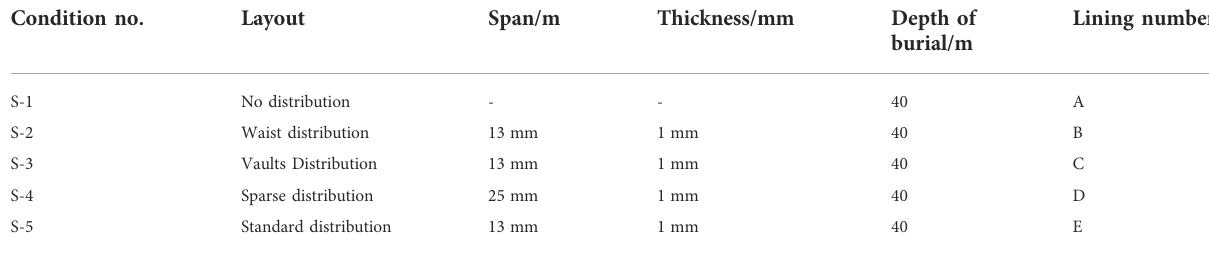
TABLE 1 Test lining models for each working condition. Condition no.